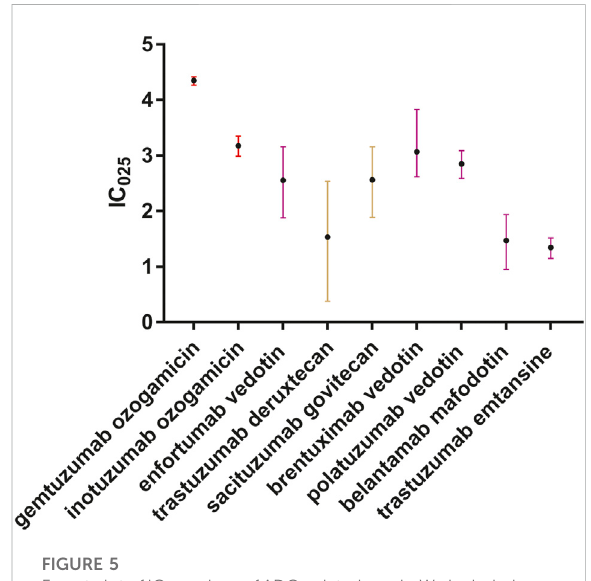
FIGURE 5 ForestplotofIC 025 valuesofADC-relatedsepsis.Weincluded all sepsis-related toxicities correlated with ADCs. Different colors stand for different payloads. Red indicates calicheamicin, brown indicatesDNA-damagingagents,andpurpleindicatestubulin polymerization inhibitors.